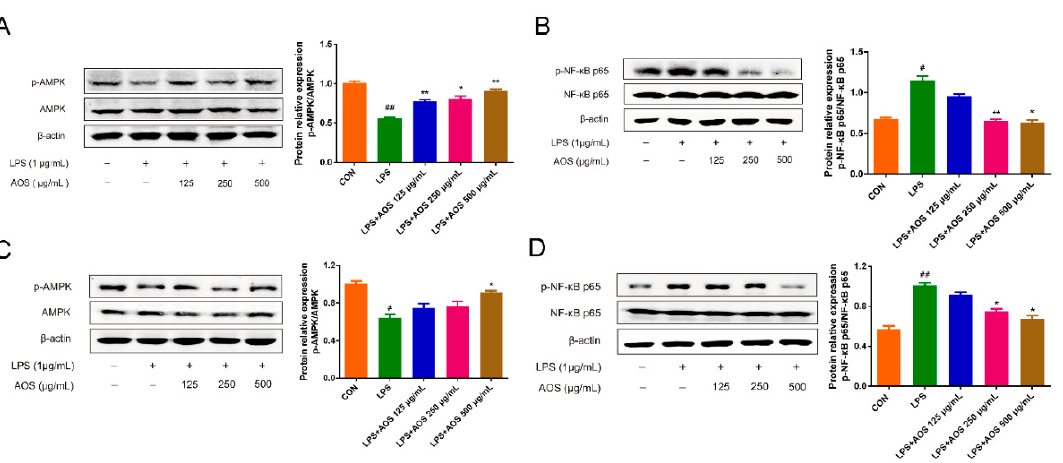
Figure 6. Effects of AOS on LPS-induced inflammation in RAW 264.7 and BMDM cells. RAW 264.7 and BMDM cells were pretreated separately with AOS at 125, 250, and 500 µ g/mL for 24 h, followed by 1 h stimulation with 1 µ g/mL LPS. Western blotting analysis of AMPK and p-AMPK levels in RAW 264.7 cells ( A ) and BMDMs ( C ), with p-AMPK/AMPK being analyzed with ImageJ software. Western blotting analysis of NF- κ B p65 and p-NF- κ B p65 levels in RAW 264.7 cells ( B ) and BMDMs ( D ), with p-p65/p65 being analyzed by ImageJ software. * p < 0.05, ** p < 0.01 vs. LPS group; # p < 0.05, ## p < 0.01 vs. Control group; n = 3.